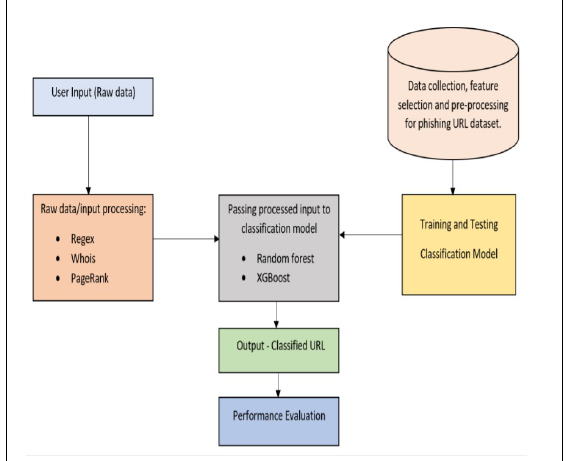
Figure 1. System